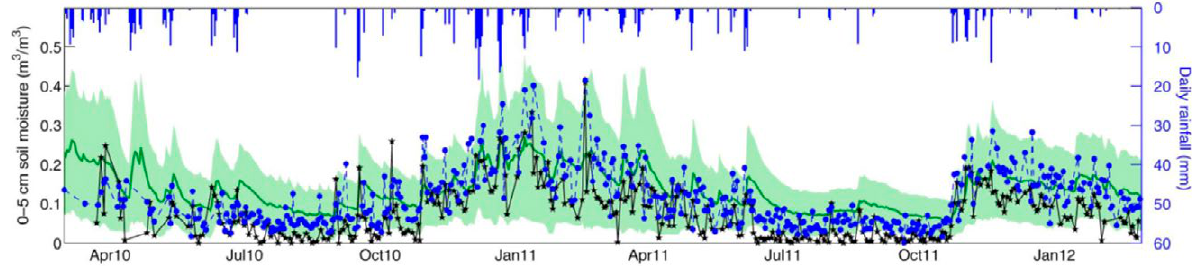
Fig. 15. – Temporal evolution of surface soil moisture time series over REMEDHUS: ground-based mean (green solid line) and standard deviation (green shaded areas), SMOS L2 (black stars), 40-km aggregated SMOS/MODIS downscaled (blue circles). Daily mean rainfall on top (from Piles et al.